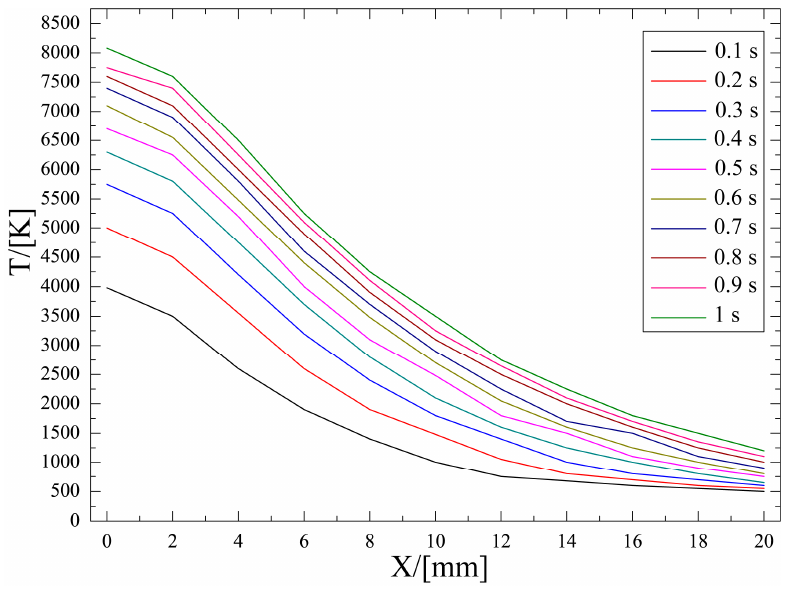
Figure 6. Temperature curve of the upper half-axis of the arc center axis (when gap is 2 mm). As can be seen from the temperature distribution cloud diagram in Figure 6, when the gap is constant at 2 mm, the arc coverage area becomes larger, and the arc temperature increases with the increase in the arc duration. The temperature of the arc center is the highest, reaching above 8000 K. As can be seen from the temperature curve of the axis, as the temperature of the arc center decreases gradually from the periphery, the temperature changes the fastest between 4 mm and 12 mm, but the maximum temperature decreases somewhat compared with the 1 mm gap of the pantograph–catenary